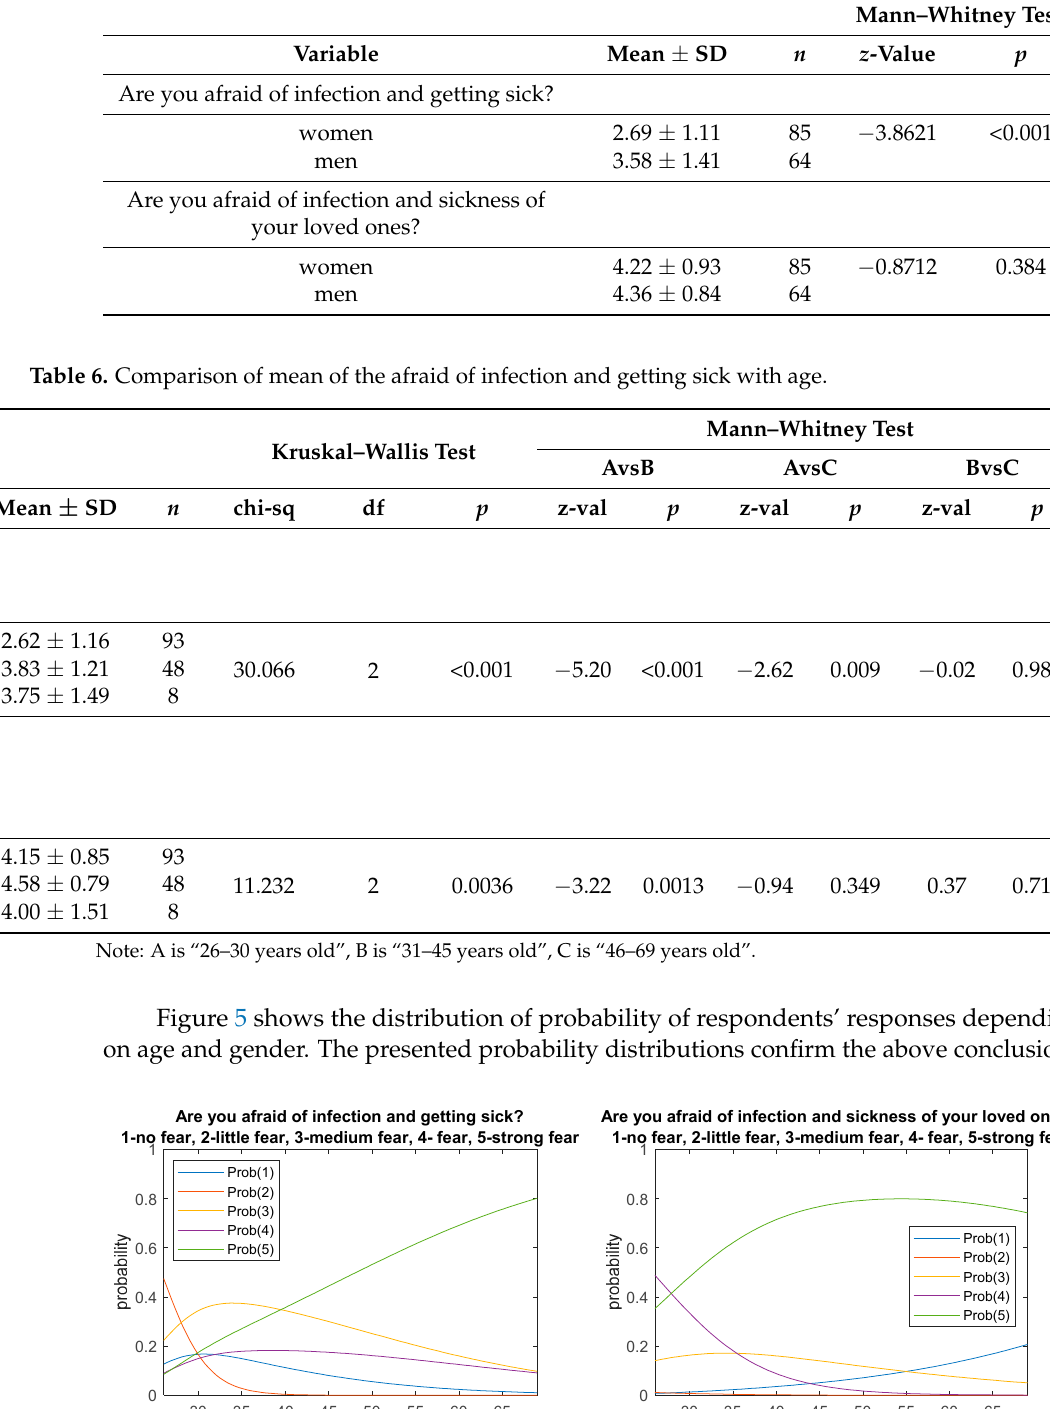
Figure 5. Response probability distributions depending on the age and sex of the respondents. 4. Discussion The aim of this study was to show the subjective feelings of Polish doctors after re- ceiving the COVID-19 vaccine. The obtained results confirm the optimistic attitude of the respondents towards their own vaccinations, who are convinced that the pandemic can be stopped in this way. The view was observed in 96% of the study participants. This opinion corresponds with the results research from Italy, which indicate that the COVID- 19 vaccine may be the only way to end the pandemic [11]. Our own research conducted shows that opinions on the effectiveness of vaccines are divided and depend on the age of doctors. Middle-aged and mature people (75%) believe that the vaccinations will bring satisfactory results. Young doctors, who constitute a minority in the studied population, are not entirely convinced about the effectiveness of the applied vaccines. However, re- search has shown some dissonance. Middle-aged doctors (31–45) who had previously stated that vaccinations would work as expected replied that they were concerned about the negative effects of the vaccine (35% of this age group). This position corresponds with